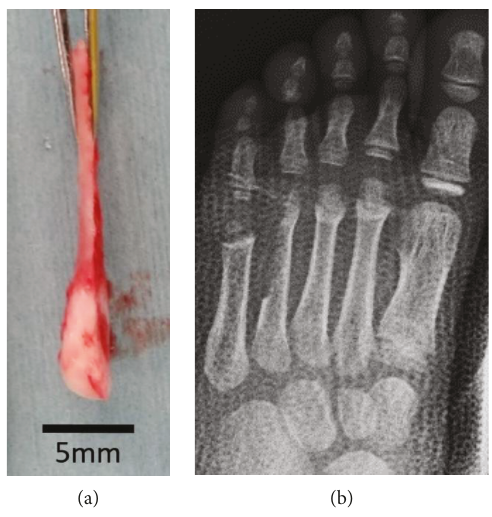
Figure 3: The metatarsal bone cut hemilongitudinally: (a) the cut metatarsal bone and (b) radiograph after the removal of the fourth metatarsal